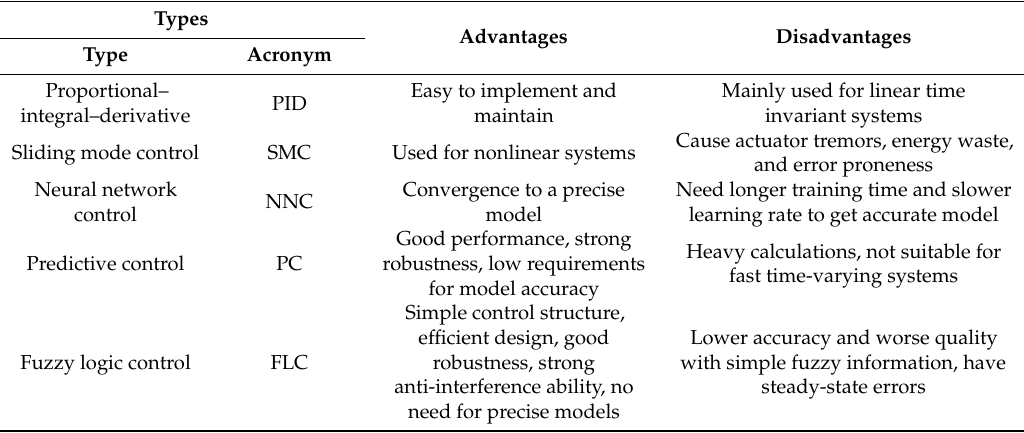
Table 1. Advantages and disadvantages of di ff erent basic control